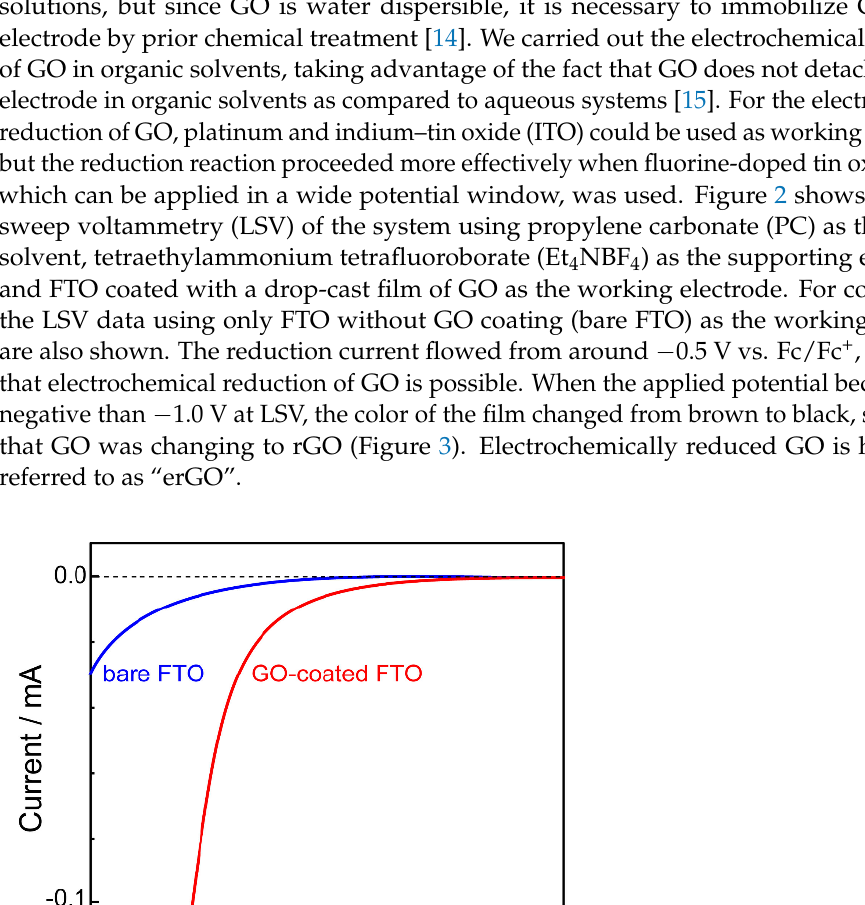
Figure 3. Photo-images of GO (left) and erGO (right). ( a ) ( b ) Figure 4. ( a ) FT-IR and ( b ) XPS spectra of erGO. In addition to its high electrical conductivity, graphene has a large specific surface area of 2600 m 2 g − 1 , which makes it promising as an electrode material for electric double- layer capacitors (EDLCs). EDLC is one of the electronic components used in a wide range of industries as a backup power source for integrated circuit (IC) and large-scale integra- tion (LSI) memories and actuators. The sweep rate dependence of the specific capacity of EDLC prepared using erGO obtained by electrochemical reduction in propylene car- bonate (PC) is shown in Figure 5. Although the rate of decrease in specific capacitance was about 20% compared to that at 10 mV s − 1 , it was found that the specific capacitance was maintained to some extent.